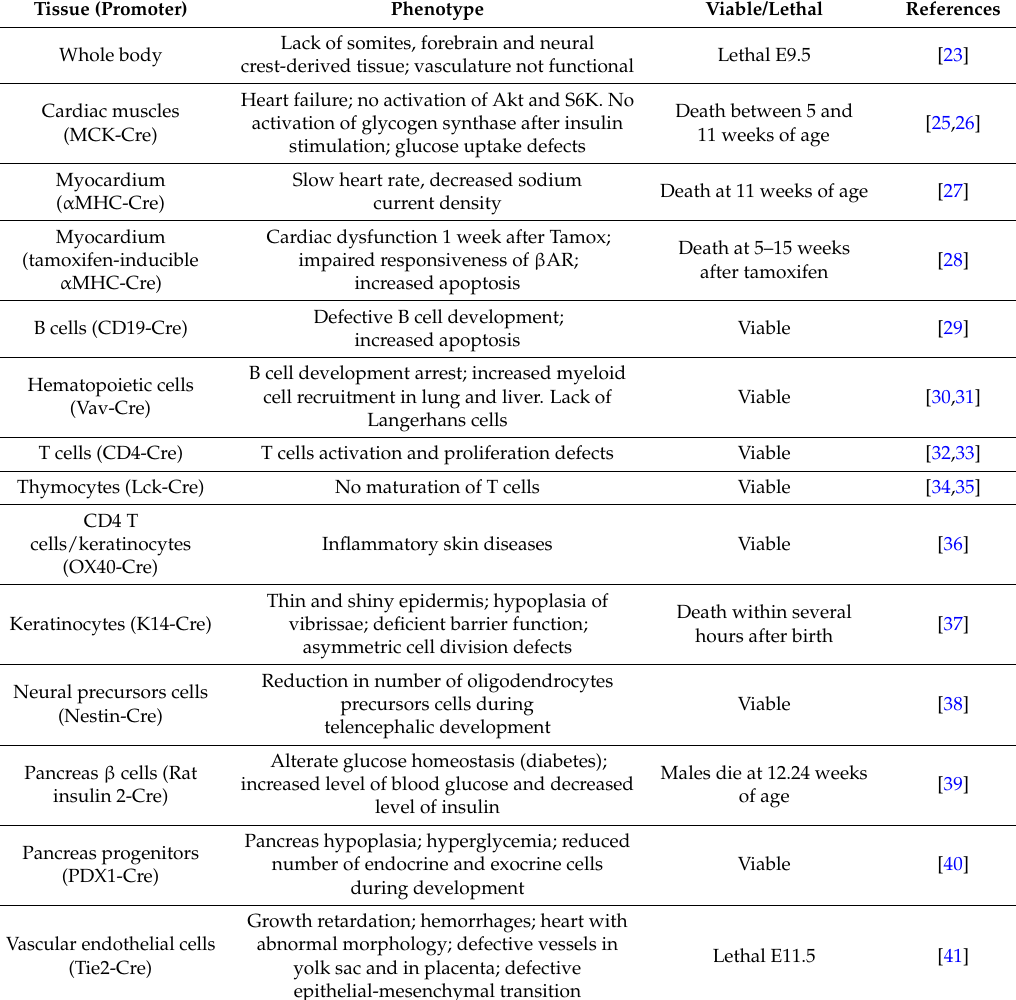
Table 1. Different PDK1 conditional knockout models are listed in the table: the first column contains the tissues affected by the knockout and the promoter used for the Cre-recombinase expression; the second column contains a brief summary of the phenotype of the knockout; and the third column indicates the viability or lethality of knockout phenotype and the time when the lethality